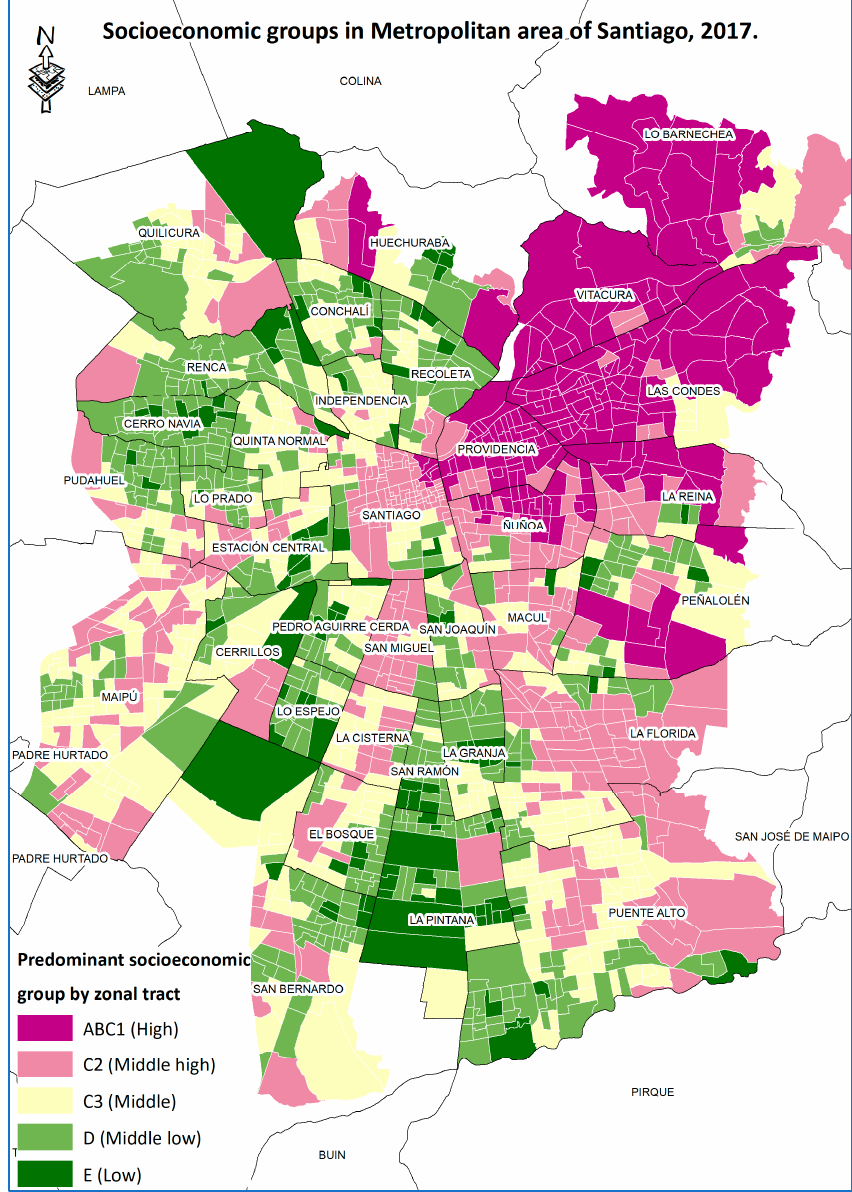
Figure 3. Distribution of socio-economic groups in the Santiago metropolitan area, 2017. Source: [42, 49]